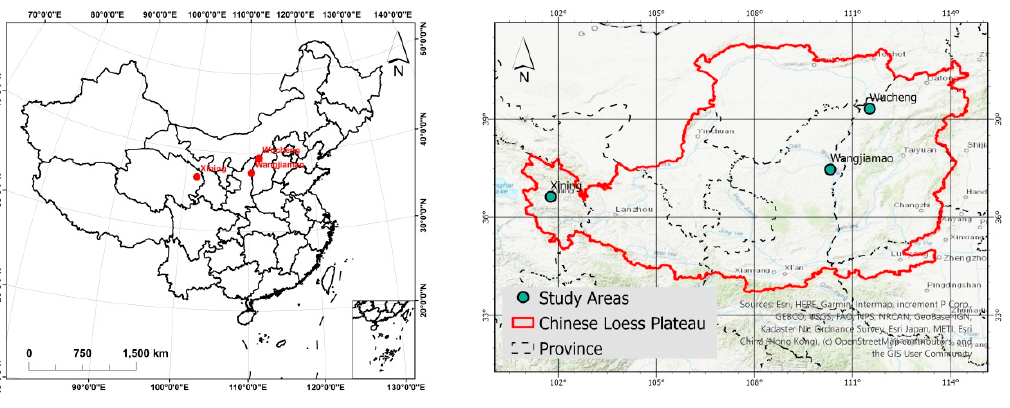
Figure 1. Study areas. Table 1. Geography of study areas.